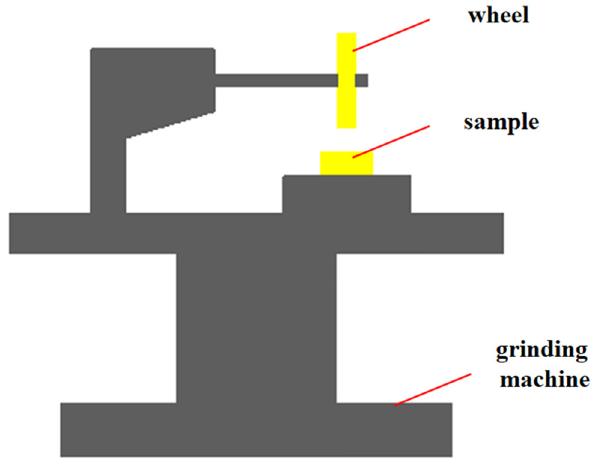
Figure 9: Schematic diagram of the grinding